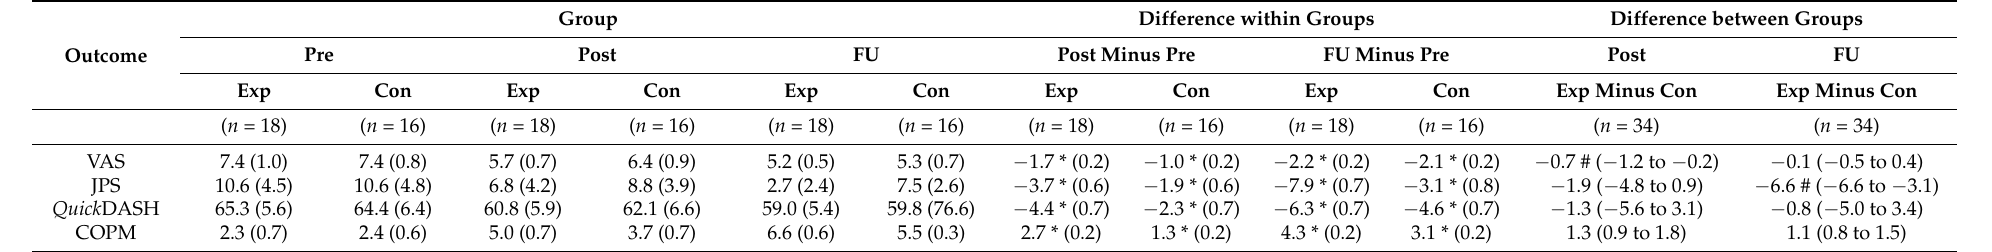
Table 2. Pain intensity, joint position sense, and quality of Life. Mean (SD) for outcomes at all study visits for each group, mean (SD) difference within groups, and mean (95% CI) difference between